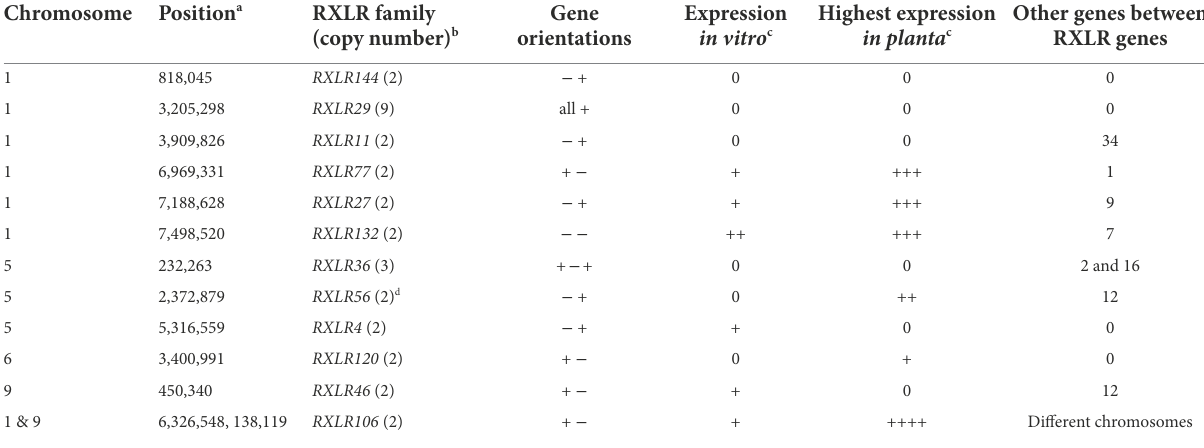
TABLE 3 Candidate RXLR gene families in the Phytophthora agathidicida genome.